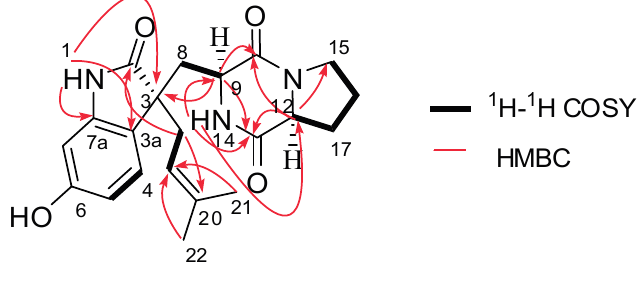
Figure 2. Key 1 H- 1 H COSY and HMBC correlations of 1 .